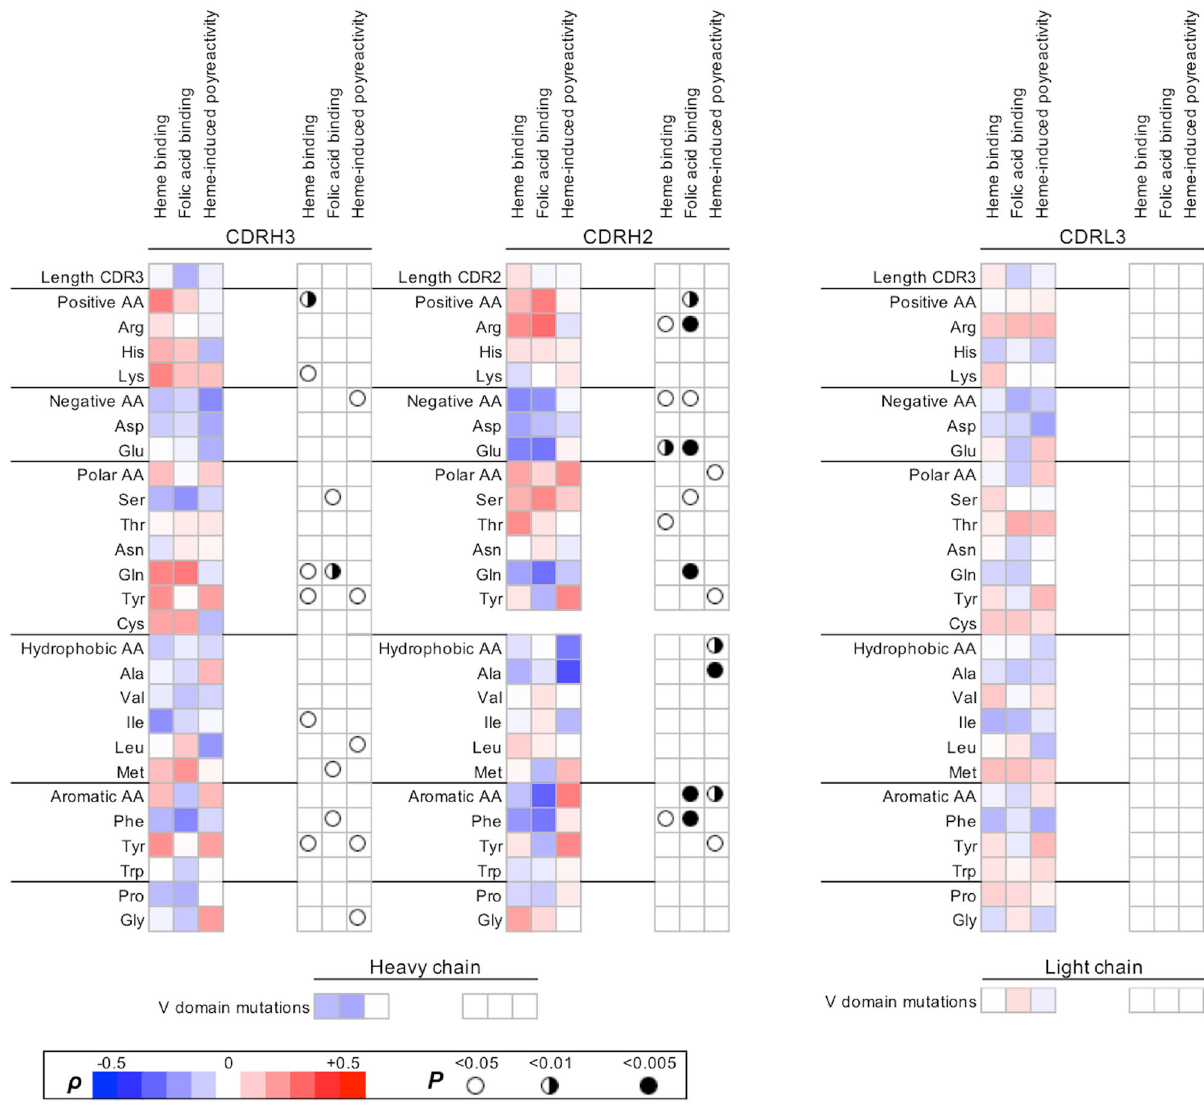
Fig. 5 Correlation between interaction with heme and sequence features of the variable regions of therapeutic Abs. The binding intensity to immobilized cofactors (heme and FA, Fig. 1b) and the degree of heme-induced antigen polyreactivity (Fig. 3a) were correlated with the sequence characteristics of heavy and light immunoglobulin chain variable regions of the studied therapeutic Abs. The heat map shows the values of the correlation coef fi cient ( ρ ) obtained after Spearman ’ s rank-order analysis of the correlation of data from the binding assays with the number of amino acid replacements in heavy chain variable region; the lengths of CDRH3, CDRH2, and CDRL3; or the number of particular amino acid residues that are present in CDRH3, CDRH2, and CDRL3. The red color in the heat map signi fi es the positive value of the correlation coef fi cient, the blue-negative. The summary of statistical signi fi cance ( P values) is depicted on the right